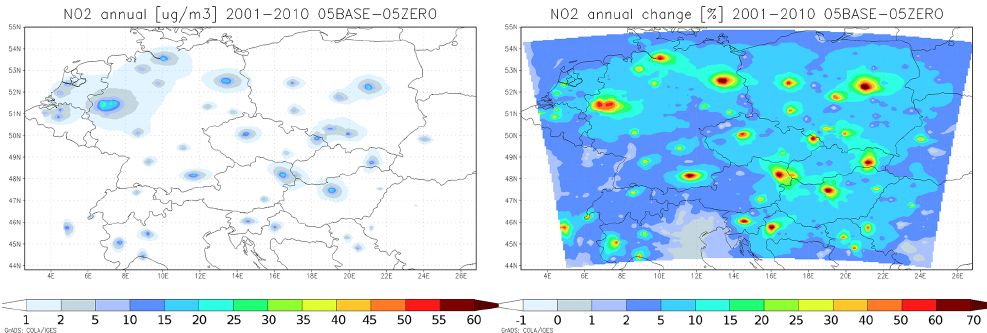
Figure 7. Impact of city emissions on the annual NO 2 concentration. Left figure presents the absolute change averaged over 2001–2010, while the relative contribution due to city emissions is shown on the